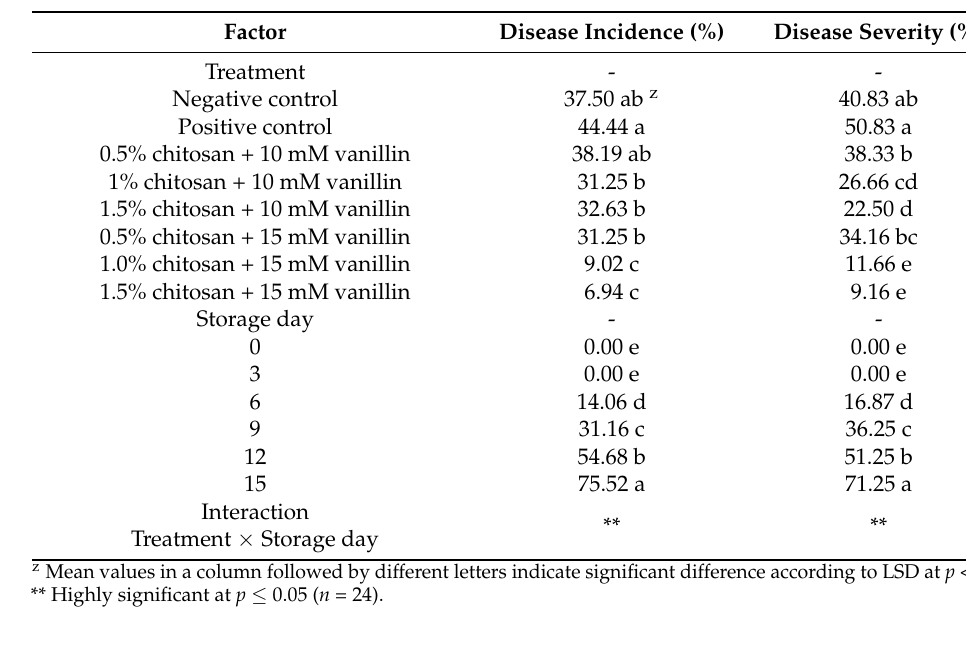
Table 2. Main and interaction effects of different coating treatments and storage days on disease incidence and severity of Fusarium oxysporum inoculated tomato fruit stored at 26 ± 2 ◦ C and 60 ± 5% relative humidity for 15 days.